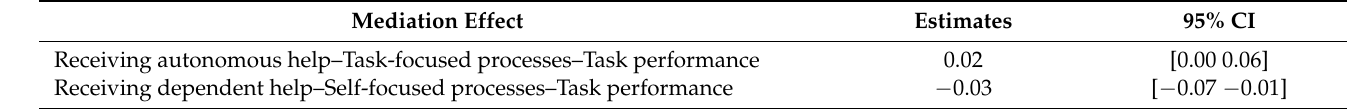
Table 4. Indirect Effect Results.